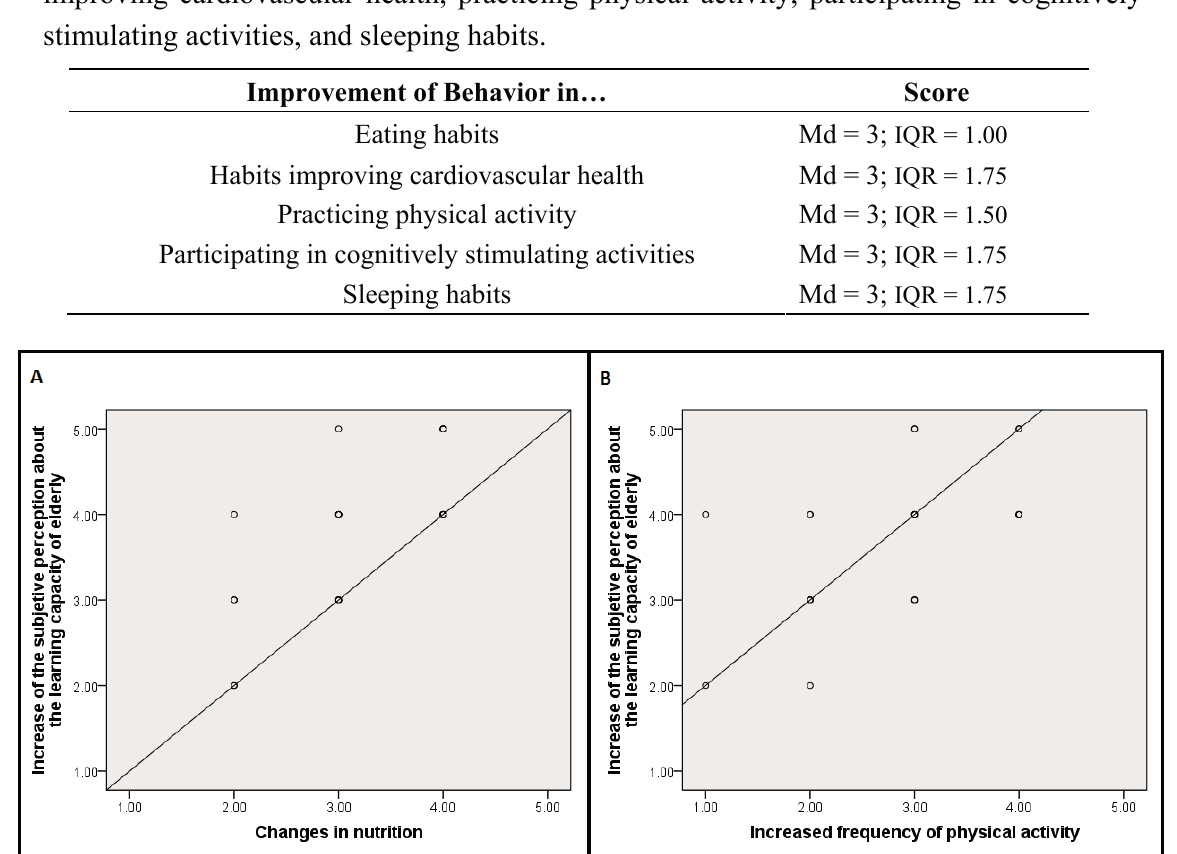
Figure 1. ( A ) Scatter plots showing the positive correlation between the increases of the subjective perception about the learning capacity of the elderly and the extent to which the respondents improved their nutritional habits; ( B ) Scatter plot showing the positive correlation between the increases of the subjective perception about the learning capacity of elderly and extent to which the respondents increased the frequency of practice of physical